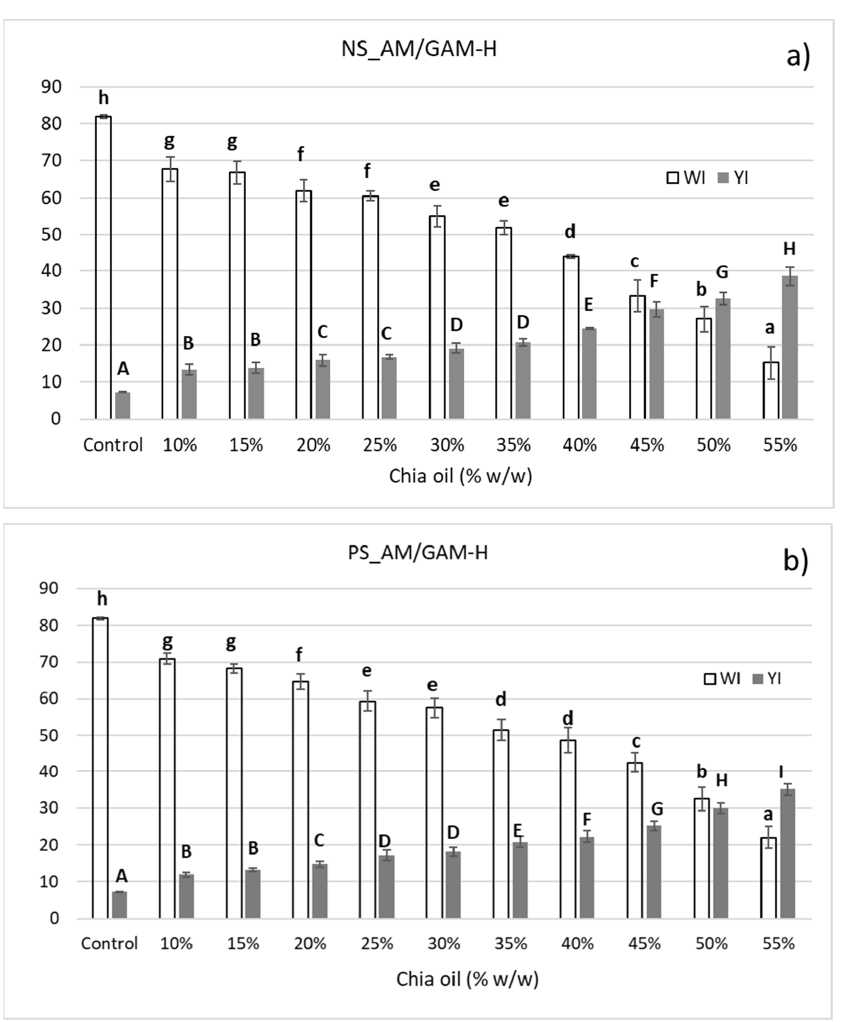
Figure 3. Colorimetric chia-oil-impregnation evaluation of NS ( a ) and PS ( b ) hydrolyzed with the mixture of α -amylase and glucoamylase with the highest dose (AM/GAM-H). WI: whiteness index; YI: yellowness index. Data shown as mean ± SD, n = 3. Lowercase letters represent the statistical analysis of the total samples; capital letters represent the statistical analysis of each starch sample separately. Means in the same column color followed by the same letter are not significantly different ( p < 0.05).